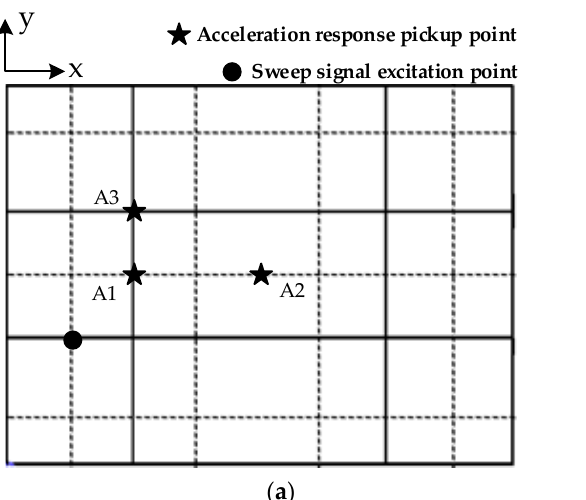
Figure 7. The actual experimental setup of the underwater vibration and sound radiation test.